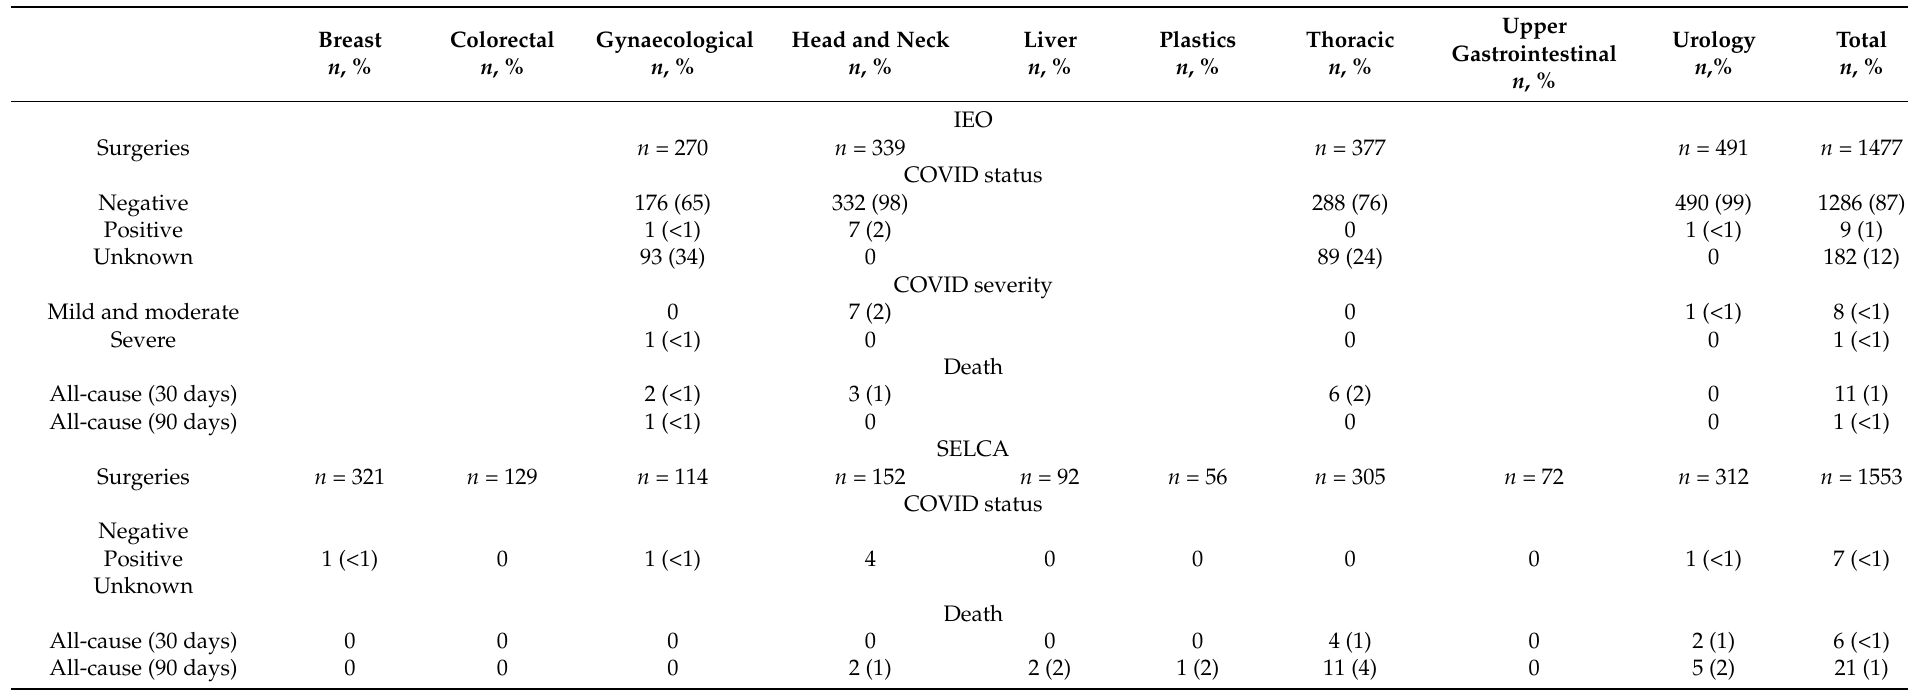
Table 3. COVID-19 outcomes of IEO and SELCA patients receiving radical treatment from between 1 March 2020–30 September 2020 and 23 March 2020–8 September 2020. Breast Colorectal Gynaecological Head and n , %